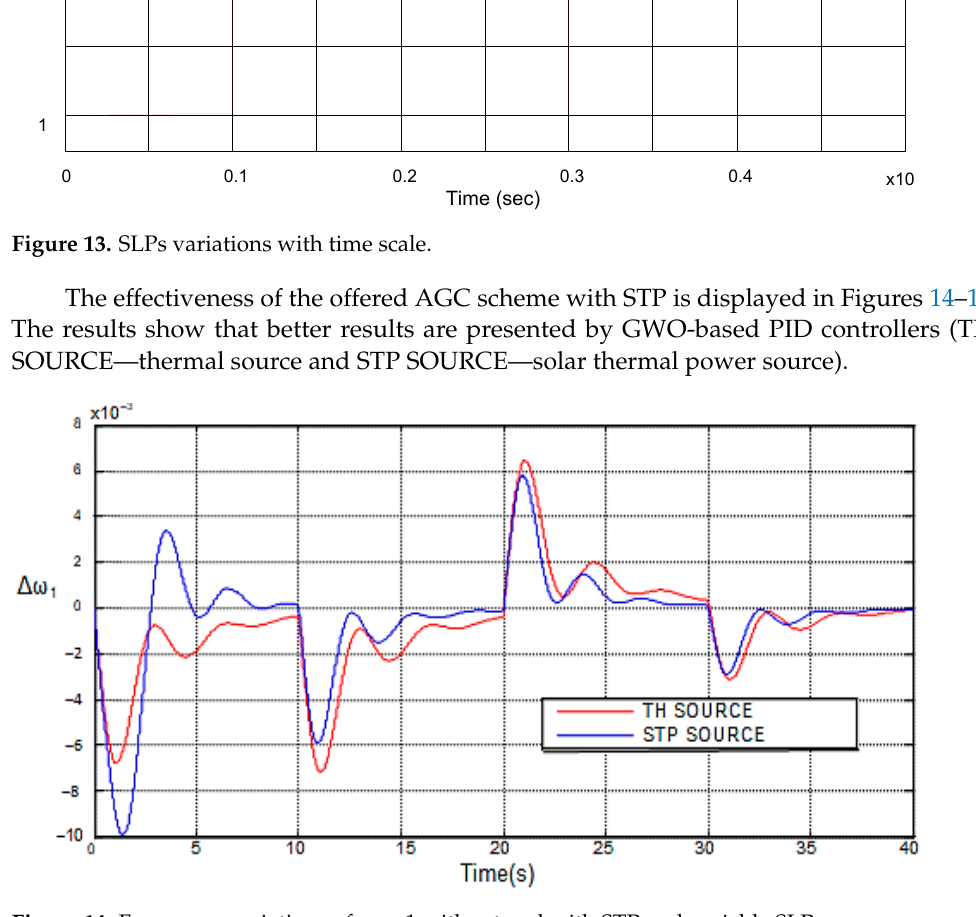
Figure 15. Frequency variations of area 2 without and with STP and variable SLP. Figure 16. Power flow fluctuations in tie line without and with STP and variable SLP.